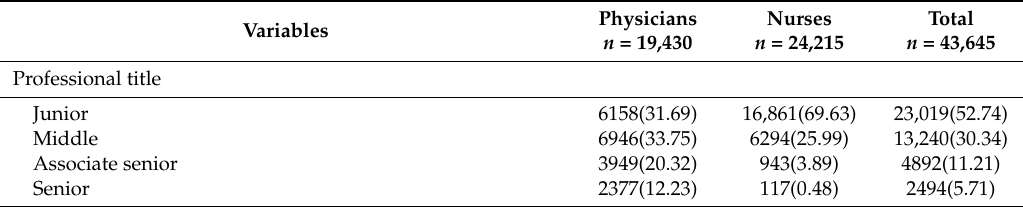
Table 3. Job-related factors of respondents, n